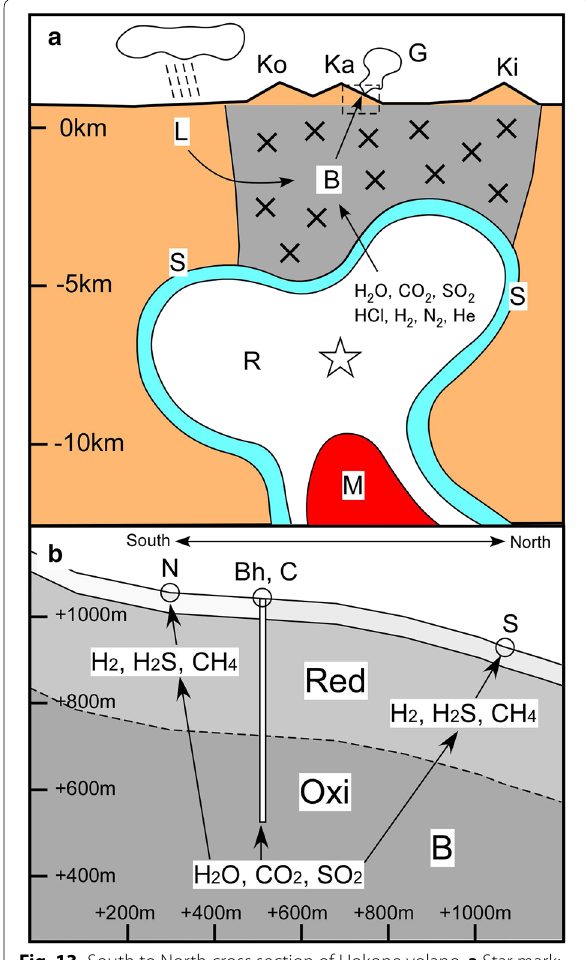
Fig. 13 South to North cross section of Hokone volano. a Star mark: pressure source appeared in 2015 (Itadera et al. 2016). M: degassing magma, R: magmatic gas reservoir, S: sealing zone, B: hydrothermal system made of brittle crust, L: local meteoric water, G: fumarolic gas, Ko: Komagatake central cone, Ka: Kamiyama central cone, Ki: Mt. Kintoki, Cross‑marks: occurrence of earthquakes. The rectangle of broken line indicates the region drawn in b . b Hydrothermal system beneath the fumarole of N, S, C and borehole (Bh). The shallow part of the hydrothermal system is reduced (Red), whereas the relatively deep part is oxidized (Oxi). The boundary between the region of Red and Oxi has not been certainly